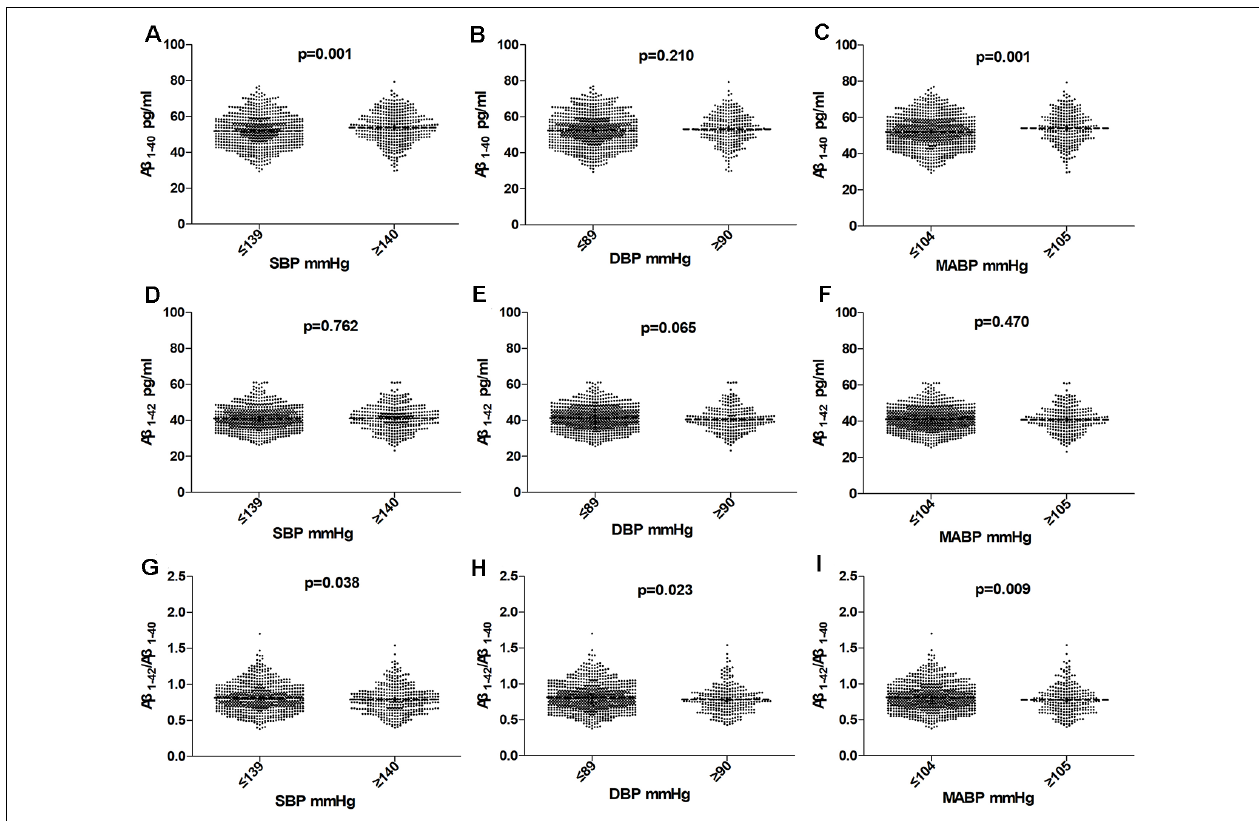
FIGURE 2 | Comparision of A β 1–40 , A β 1–42 , and A β 1–42 /A β 1–40 in subjects according to SBP (A,D,G) , DBP (B,E,H) , MABP (C,F,I) in the total population. Horizontal lines represent the mean and 95% CI. Abbreviations: BP, blood pressure; SBP, systolic blood pressure; DBP, diastolic blood pressure; MABP, mean arterial blood